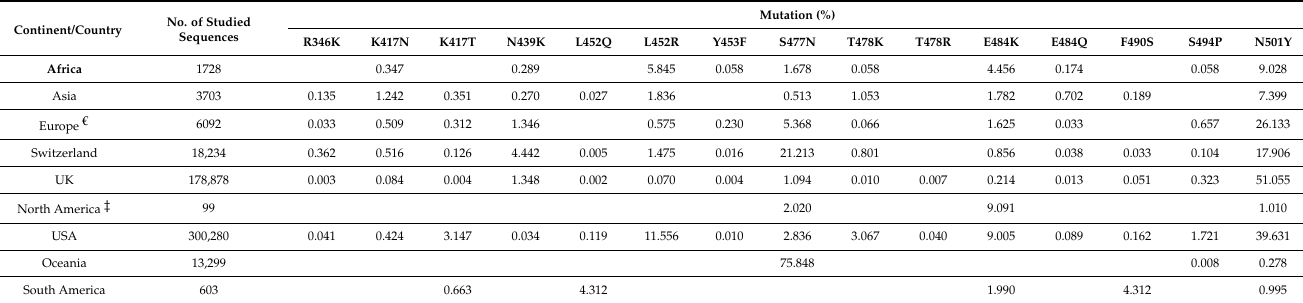
Table 2. Continent/country-wise prevalence of adaptive mutations in the receptor-binding domain of the SARS-CoV-2 spike protein until 29 May